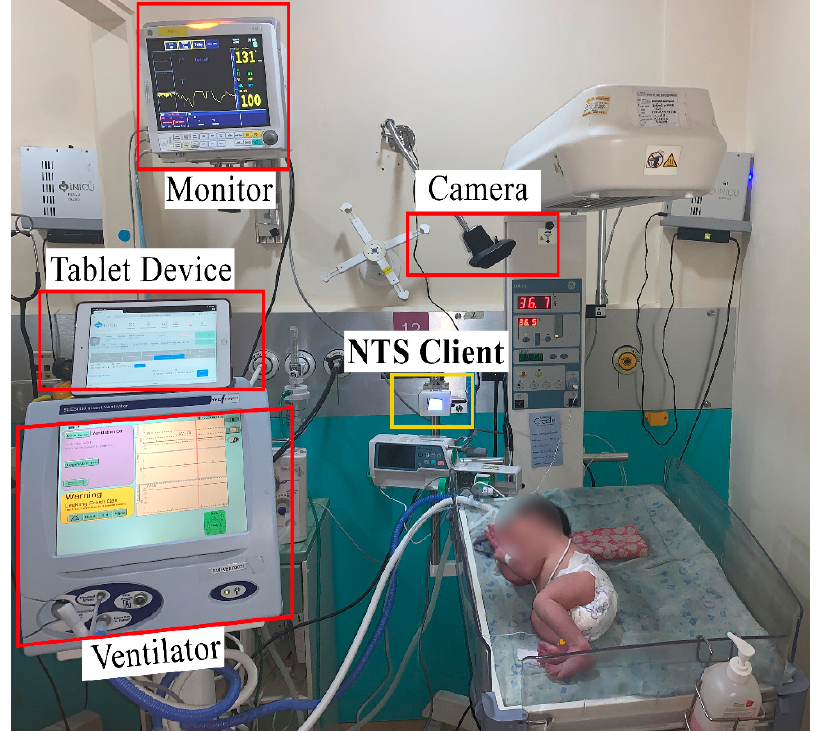
Figure 1. NEO TINY system (NTS) client module in typical Neonatal Intensive Care Unit (NICU) settings (box with yellow-colored border highlight the NTS client, and red-colored boxes highlight other devices).